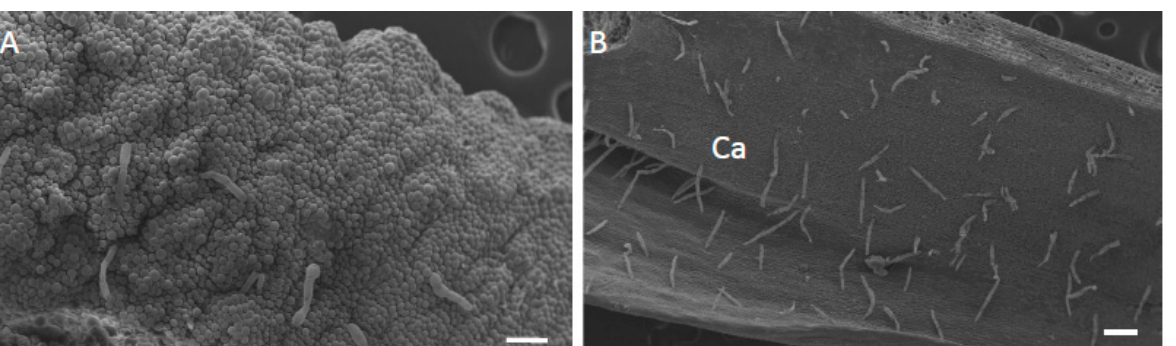
Figure 4. ( A – F ). Adaxial surface of the labellum of M. pauciflora , SEM. ( A ). Apical part of labellum bearing clusters of elevated papillae and few-celled trichomes. ( B ). Callus region with trichomes and typical epidermal cells. ( C ). Multicellular trichomes on callus and marginal part of labellum. ( D ). Multicellular trichome with smooth, seemingly intact cuticle, located on apical part of labellum. ( E , F ). Elevated papillae on apical part of labellum. Note that the smooth cuticle lacks traces of secre- tion. Scale bars = 100 µm, 200 µm, 30 µm, 20 µm, 10 µm, 10 µm, respectively. Ca = callus.